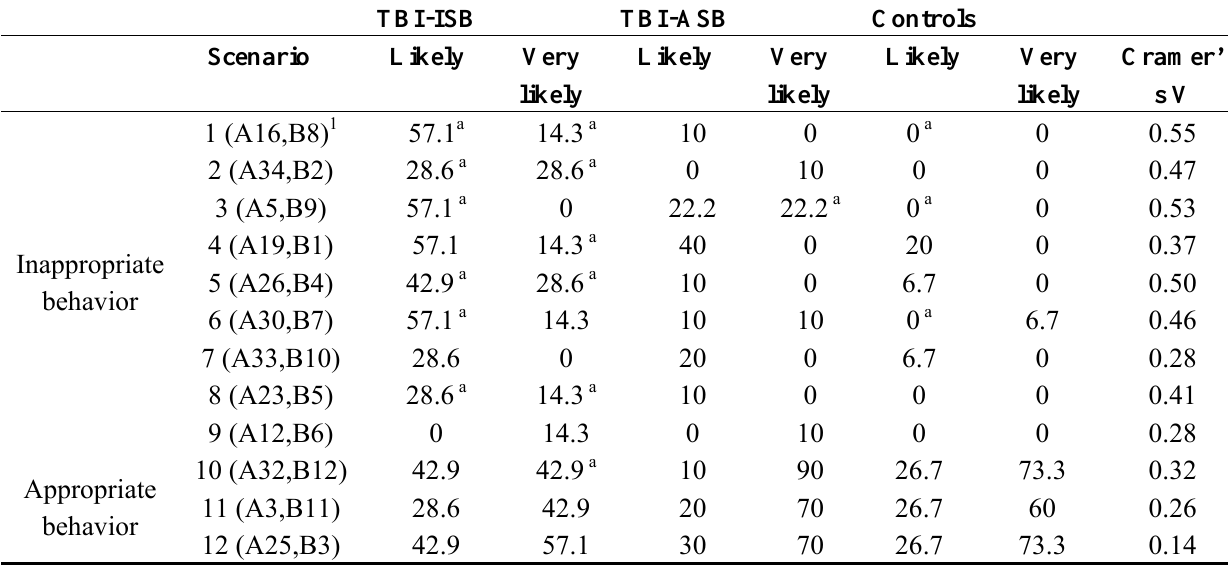
Table 3. Percentage of participants by group who endorsed inappropriate behaviors and appropriate behaviors as “likely” or “very likely” that they would have reacted in the same way had they been in that